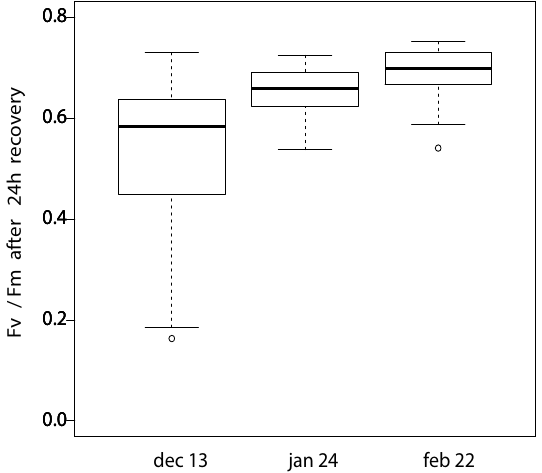
Figure 5. FT of barley varieties assessed in winter 2011/2012 on leaves harvested from experimental plots at CRA-GPG, Fiorenzuola d’Arda, Italy. Freezing stress at − 14 °C. Box plots represent measurement of 30 barley varieties